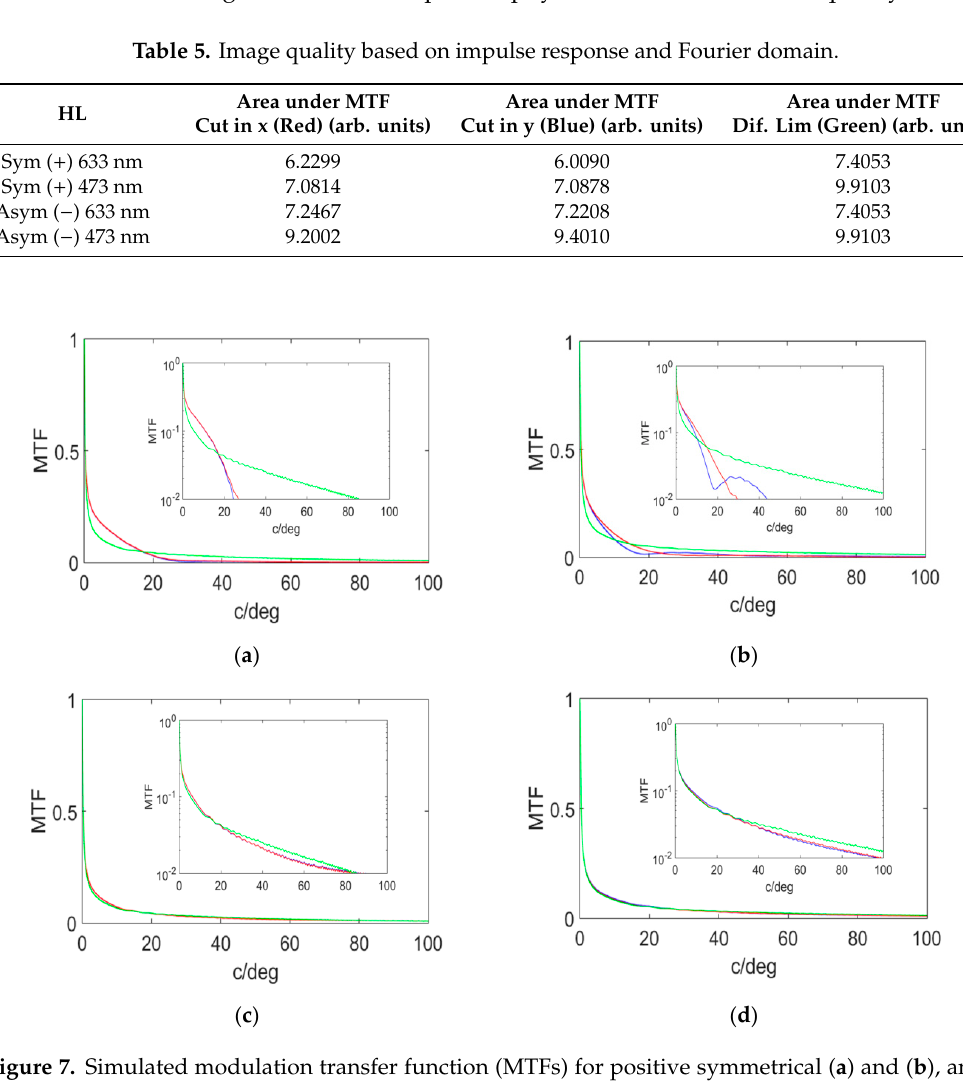
Table 4. Image quality based on impulse response and Fourier domain.